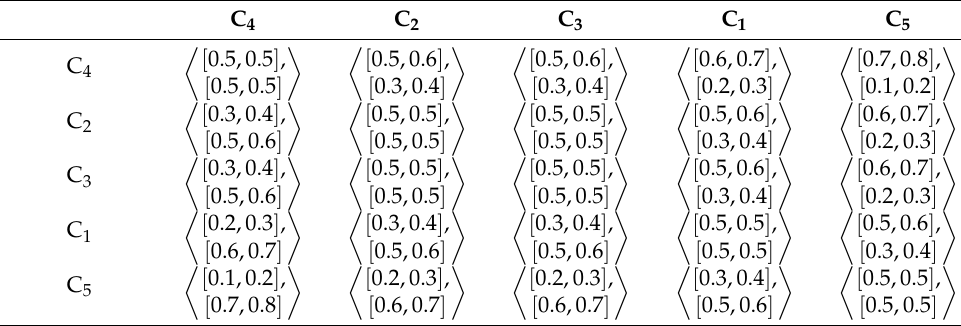
Table 16. Aggregated decision interval matrix in IVPF–AHP for the sub-criteria C (CI = 0.0317228, CR = 0.0283239).